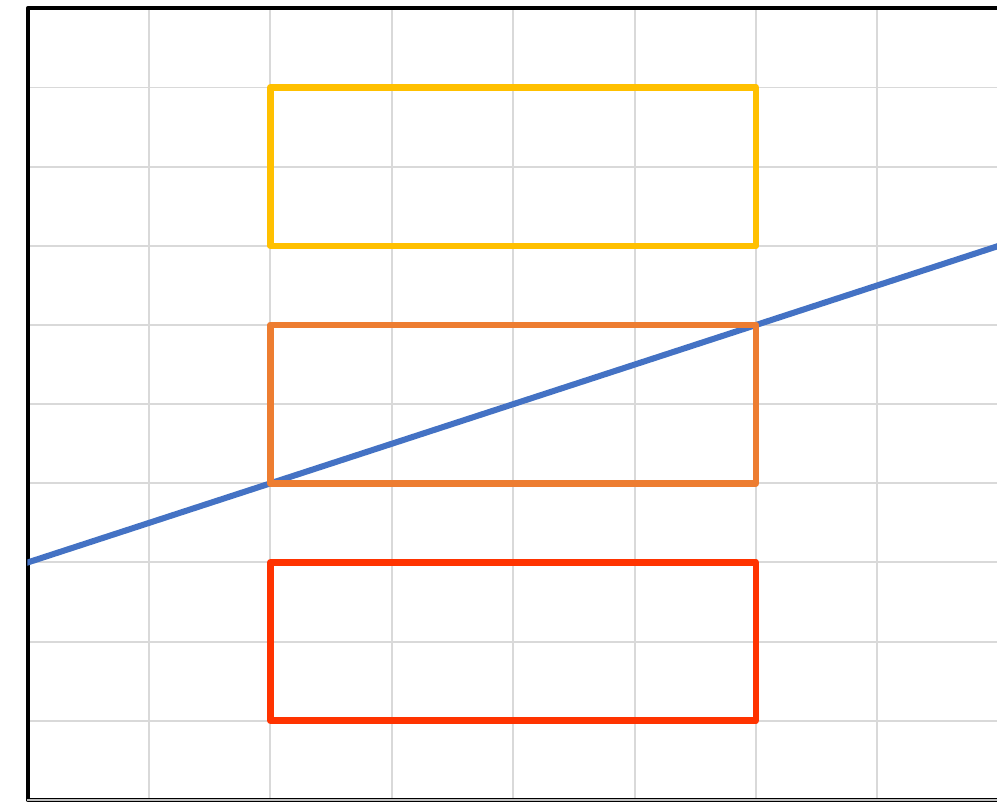
Figure 4. Environmental conditions encountered by the model organisms. For a given combination of environmental nutrient content N and environmental fat content F , it is adaptive to switch on fat synthesis if 1 N − c ) ) and to switch it off otherwise. The three boxes ( N , F ) is below the blue line (corresponding to F < k ( illustrate three types of environment: a low-fat environment (red) where fat synthesis should be switched on constitutively; a high-fat environment (yellow) where fat synthesis should be switched off constitutively; and an intermediate-fat environment (orange) where a plastic switch is selectively